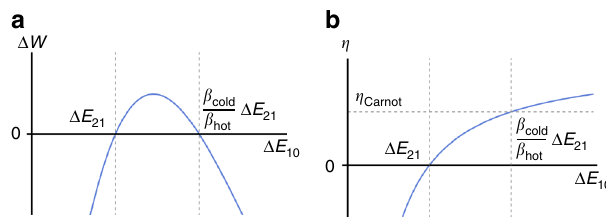
Fig. 3 Energy extraction and ef fi ciency with a qubit machine. Consider a qutrit system with Hamiltonian H P ¼ ρ a given passive state depends on the Hamiltonian of the system. This